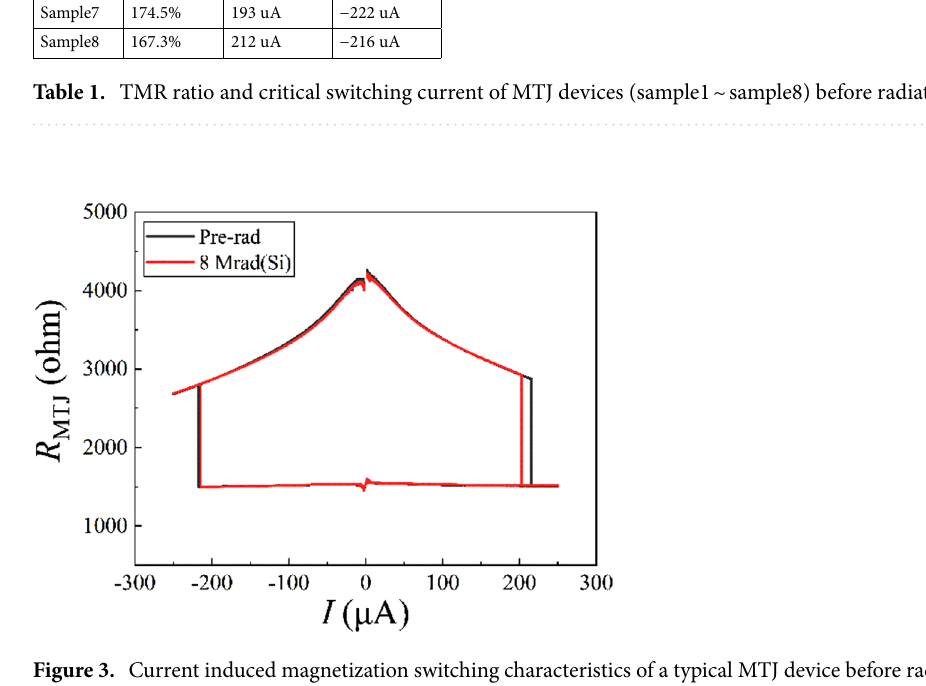
Figure 3. Current induced magnetization switching characteristics of a typical MTJ device before radiation and after 8 Mrad(Si) X-ray radiation. Sample 1 ~ sample8 are randomly selected eight